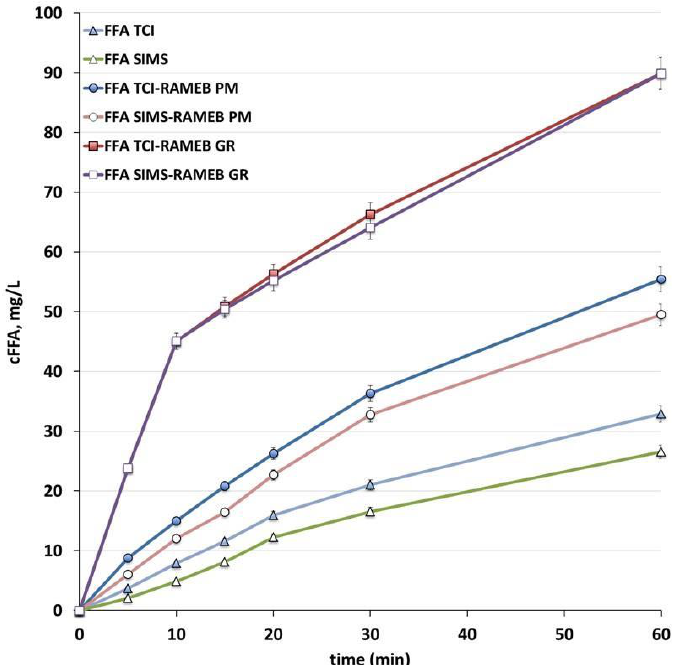
Figure 4. Dissolution profiles of FFA from conventional tablets for enteric coating (CT) containing the drug, provided by TCI or SIMS, as such or as physical mixture (PM) or co-ground product (GR) with RAMEB.